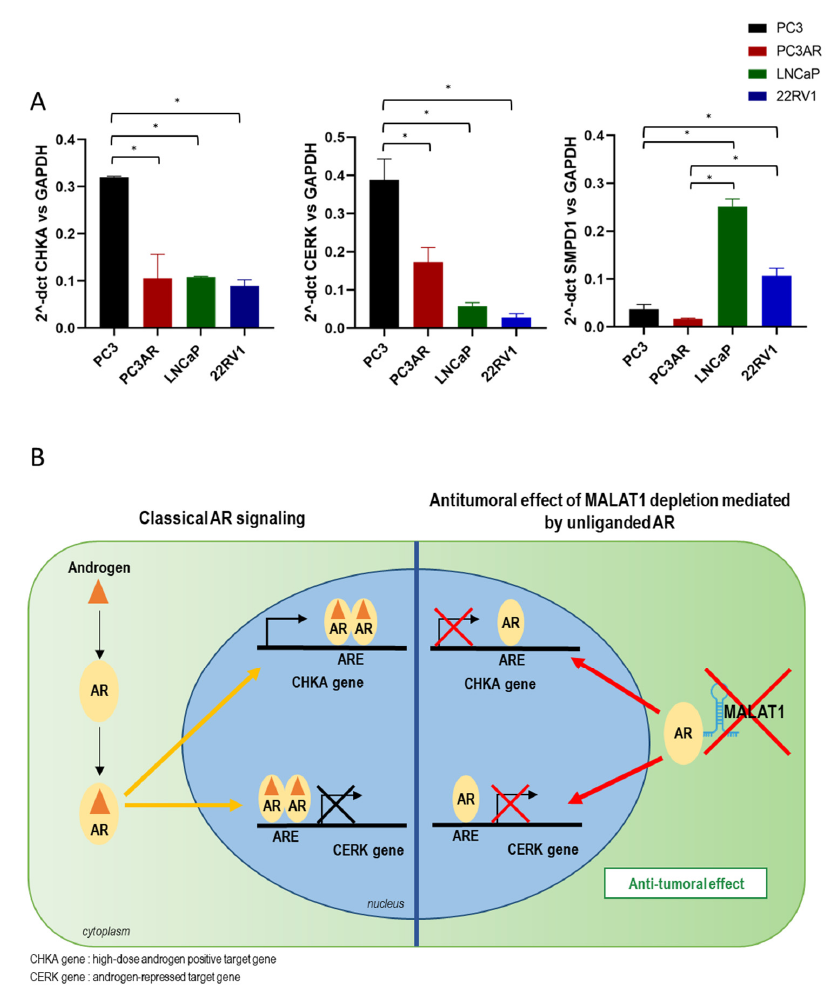
Figure 8. The basal level of CHKA, CERK, and SMPD1 mRNA in different PCa cell lines: ( A ) Quantification of CHKA, CERK, and SMPD1 by qPCR. Data were normalized to GAPDH expression. Data are represented as the mean of 2- Δ Ct ± SEM ( n = 3). * p < 0.05. ( B ) The antitumoral Data are represented as the mean of 2- ∆ Ct ± SEM ( n = 3). * p < 0.05. ( B ) The antitumoral effect effect of MALAT1 targeting. Schematic cartoon showing the role of MALAT1 in androgen receptor signaling in advanced prostate cancer. The metabolic genes CHKA and CERK are transcriptionally regulated by androgen/androgen receptor (AR) on Androgen Responsive Element (ARE) sites (Left). MALAT1 reduces AR activity by forming a MALAT1/AR complex without androgens. tumoral activity (Right).